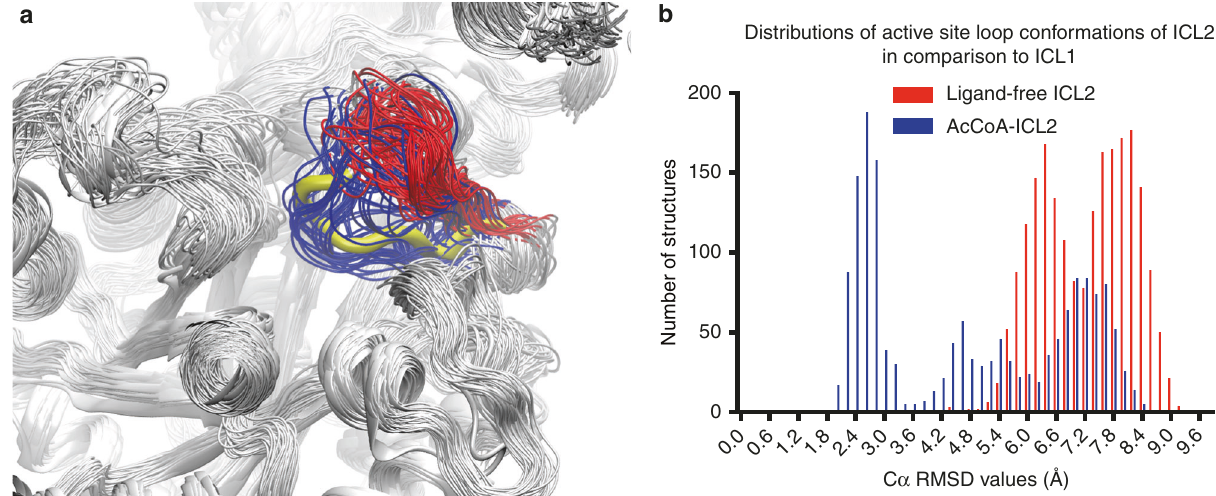
Fig. 3 Active site loop conformations in ICL2. a Active site loop (residues 213 – 217) conformations sampled during MD simulation for ligand-free (red) and acetyl-CoA-bound (blue) ICL2. The active site loop in crystal structure of ICL1 in complex with isocitrate (PDB 3P0X) is superimposed and displayed as thick yellow ribbons. The rest of the enzyme structures are displayed in white for clarity. b Distributions of the RMSD values between the active site loop in ICL1 (residues 183 – 187, PDB 3P0X) and those in ligand-free and acetyl-CoA-bound ICL2 (residues 213 –